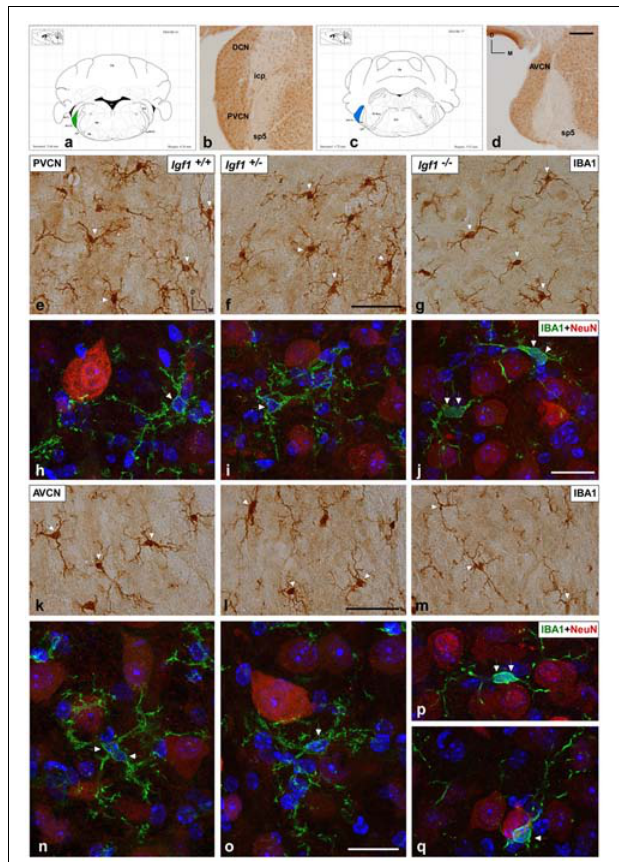
FIGURE 3 | IBA1 immunostaining in the PVCN and AVCN of Igf1 − / − mice. (A,C) Coronal sections of a wild-type mouse brain, taken from Franklin and Paxinos (2013) mouse brain atlas, showing the location of the PVCN (green) and AVCN (blue). (B,D) Representative coronal sections of the ventral cochlear nucleus in the wild-type genotype immunostained with IBA1. In the PVCN and AVCN of Igf1 − / − mice, there was less staining ( G,J,M,P,Q ) relative to the Igf1 + / + (E,H,K,N) and Igf1 + / − mice ( F,I,L,O ). Maximum intensity projections of confocal images from the PVCN and AVCN show the reduced microglial arborization in Igf1 − / − mice as compared to the other genotypes ( H–J,N–Q for the PVCN and AVCN; respectively). Arrows point to IBA1 immunostained cells. Cell nuclei are stained with DAPI